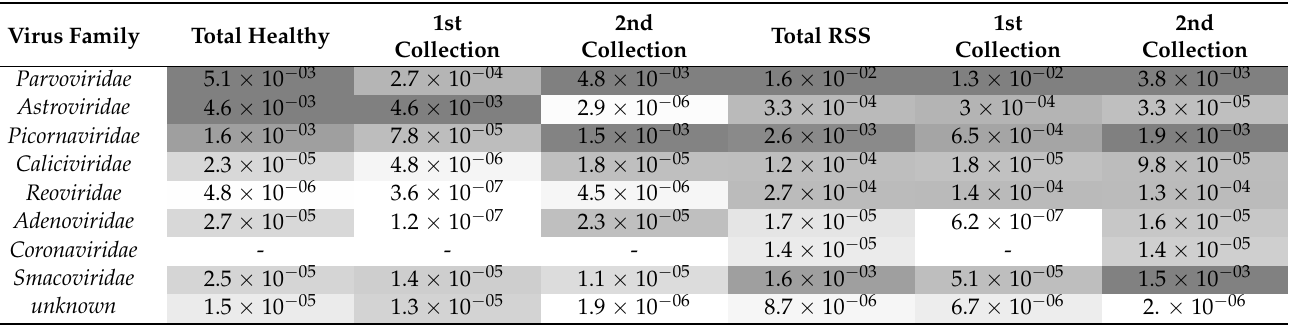
Table 1. Normalized number of viral reads detected in samples at two different sampling time points. The color gradient represents the numbers of viral reads from the 15 percentiles of the lowest number (white) to the 85 percentiles of the highest number (dark